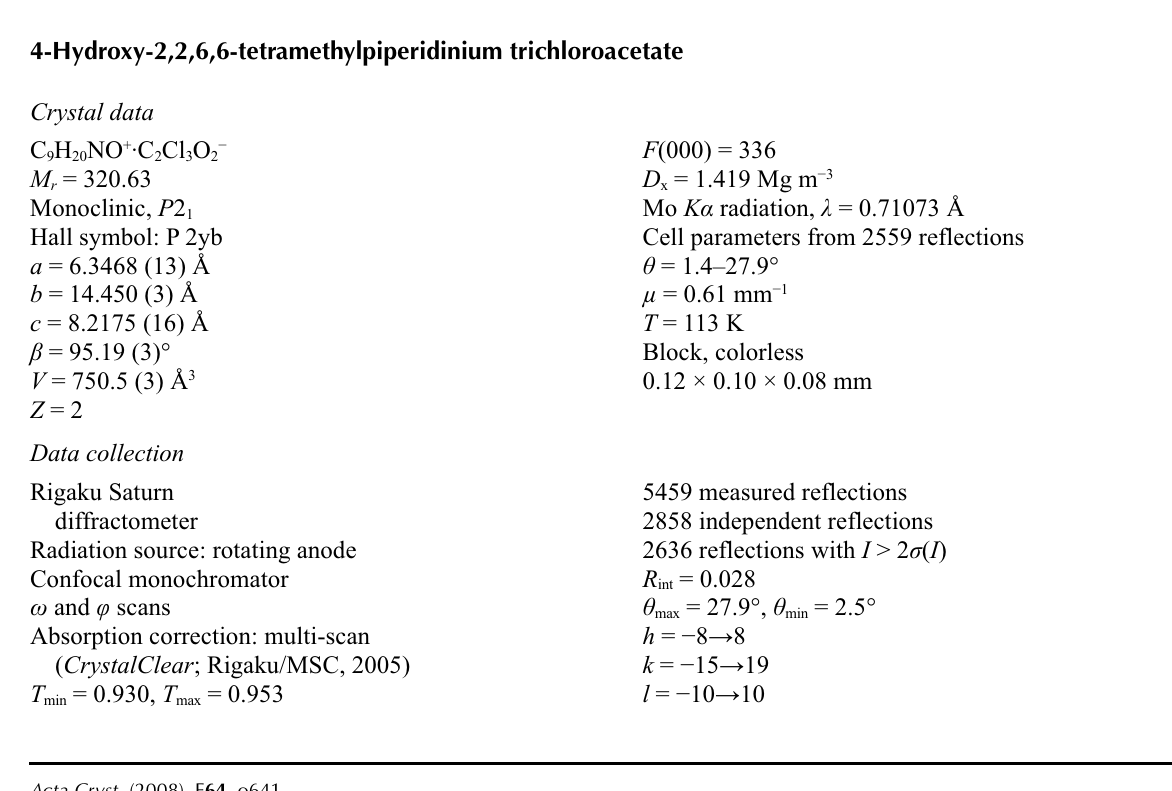
Crystal structure of the title compound with atom labeling and displacement ellipsoids drawn at the 30% probability level. H atoms are shown as small spheres of arbitrary